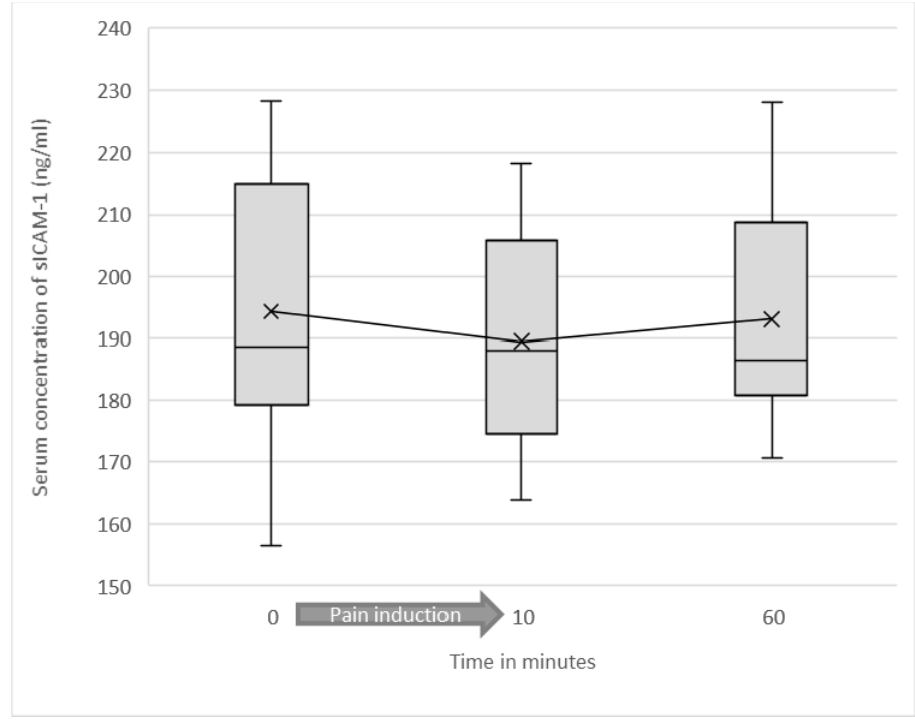
Figure 4. Soluble ICAM-1 serum concentrations as a function of test duration in the high-intensity heat pain group are shown as a box plot diagram.